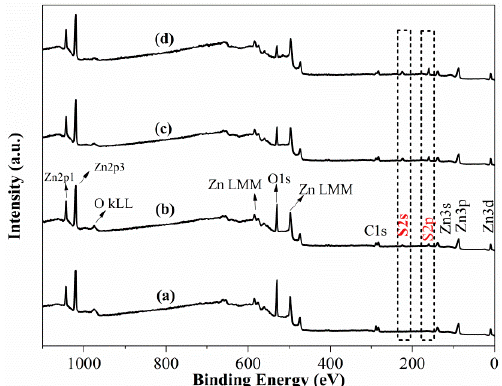
Figure 4. XPS survey scan spectra of smithsonite treated with ( a ) 0, ( b ) 0.5 × 10 − 3 , ( c ) 2.5 × 10 − 3 and ( d ) 10 × 10 − 3 mol / L Na 2 S · 9H 2 O.